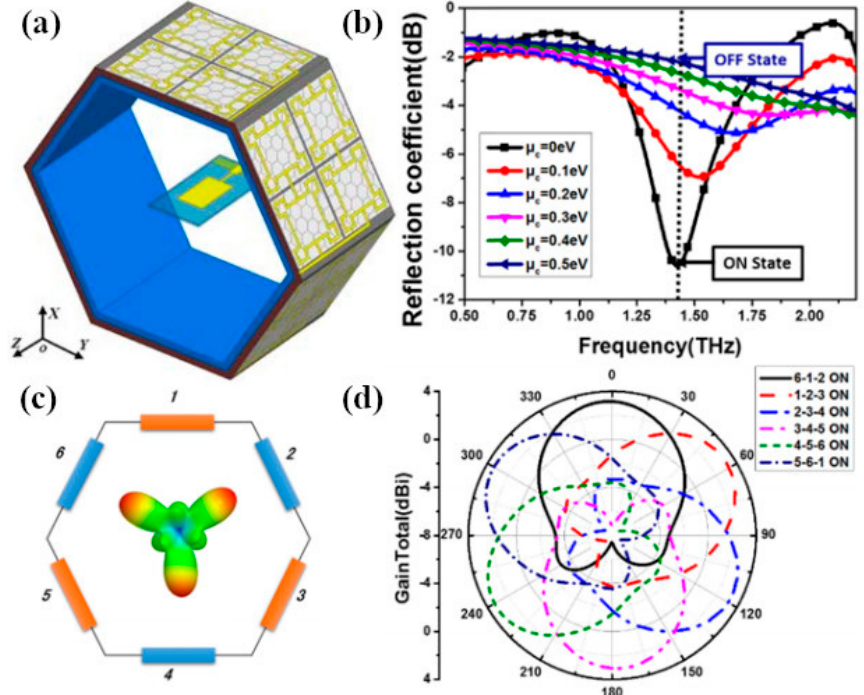
Figure 17. ( a ) Monopole THz antenna integrated with reflective frequency-selective surfaces; ( b ) Magnitude of the reflection coefficient by increasing the chemical potential and consecutively switching the frequency-selective surfaces (FSSs) on/off; ( c ) Schematics of the switch on/off scenario for FSSs; ( d ) 360° radiation beam scanning by alternatively switching the FSSs on/off. © 2018 OSA, Reprinted with permission from [235].